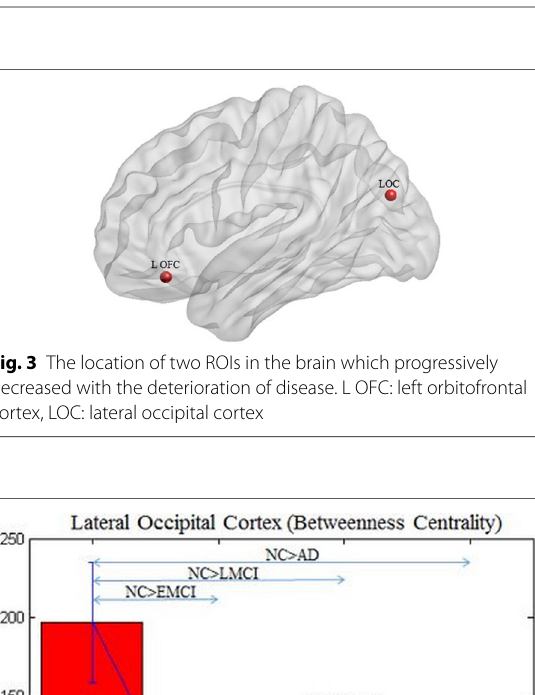
Fig. 2 Middleman power (MP) of the left orbitofrontal cortex (L OFC) and lateral occipital cortex (LOC), which were significantly different between the groups and deteriorated from NC to EMCI to LMCI to AD